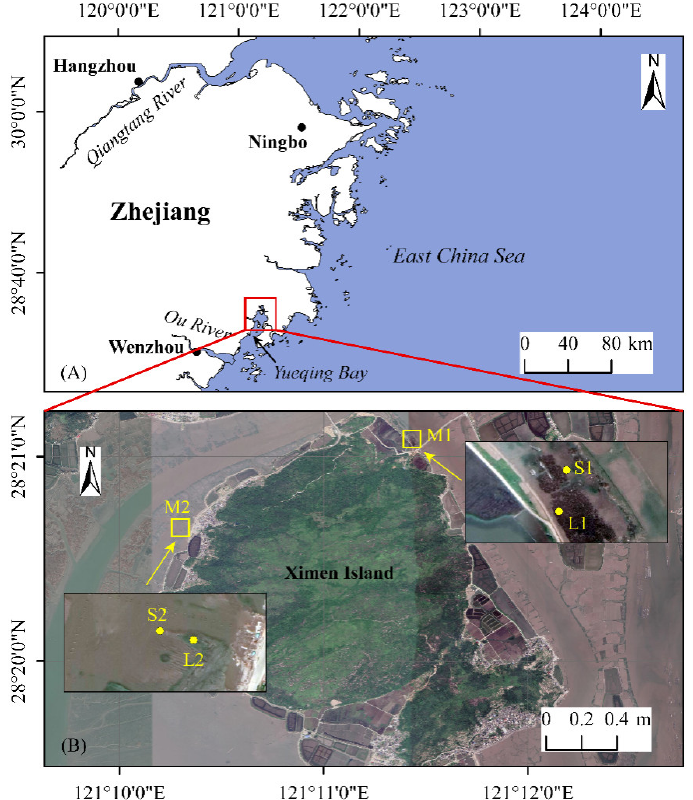
Figure 1. ( A ) Map showing the Ximen Island mangrove area in the northern part of Yueqing Bay, Zhejiang Province; ( B ) magnification of the four sampling locations (L1, S1, L2, S2) from two man- grove ecosystems (M1 and M2) are set in the mangrove